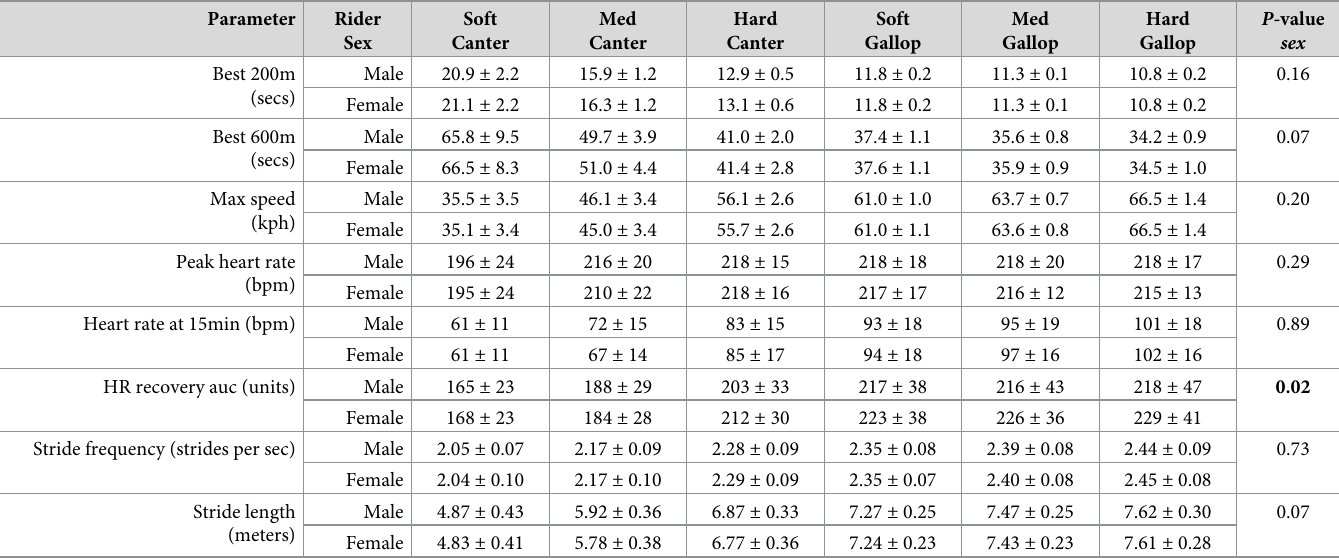
Table 1. Descriptive data for the complete cohort of racehorses training at a single racing yard in